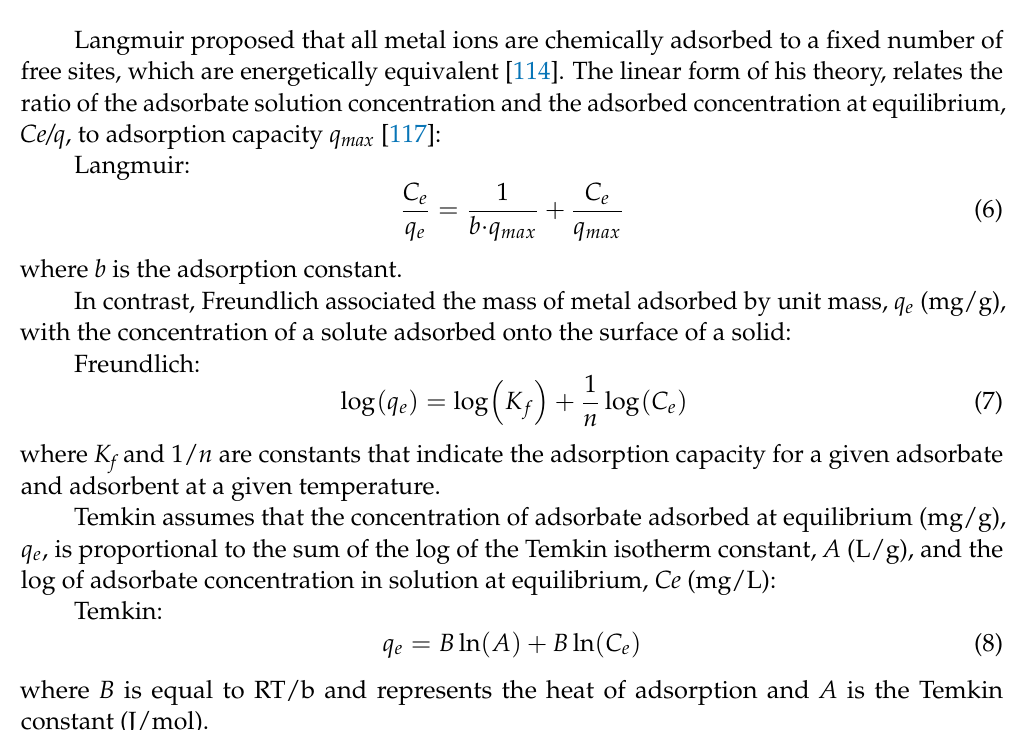
Table 6. Surface area normalized adsorption maximum values of Cd adsorption for HC and PC.